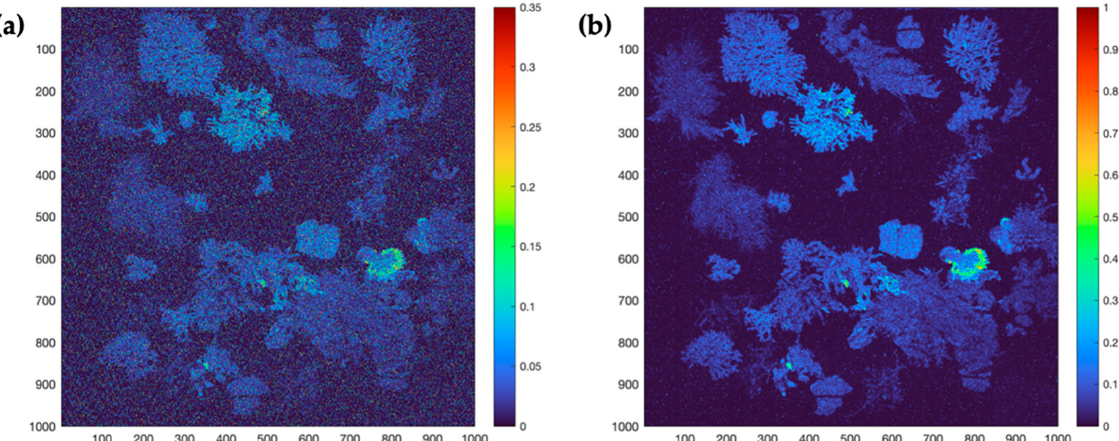
Figure 12. Pixel intensity variance between image replicates ( a ) not denoised; ( b ) denoised using 3 × 3 median filter) generated by laser excitation at 490 nm, and corresponding fluorescence at 685 nm in various macroalgae and coral species. Note an area of high variance that can be attributed to soft coral-associated structure and polyp contraction between image takes (i.e., approx. 30